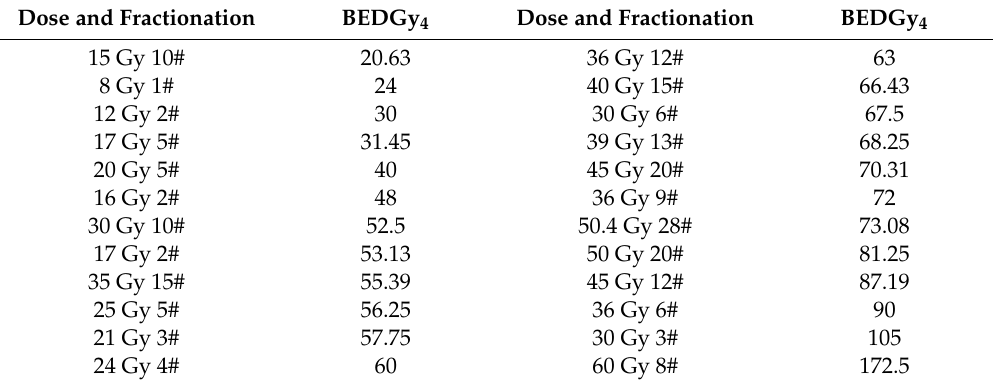
Table 4. Dose and fractionation regimens expressed as biological e ff ective dose (BEDGy 4 ). Dose and